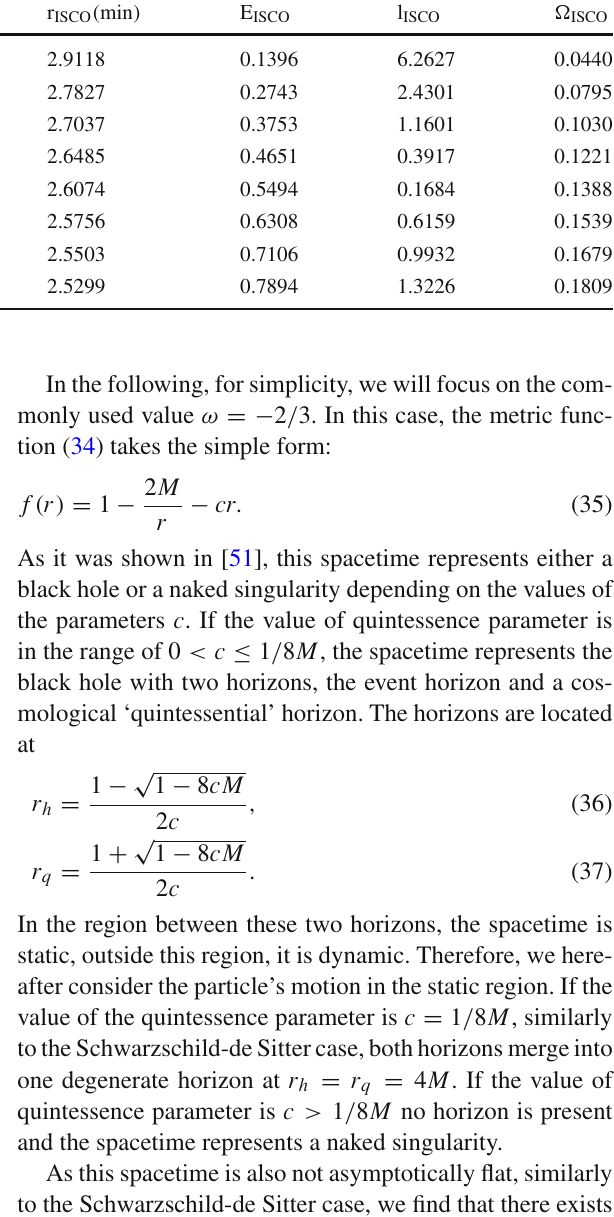
Table 1 Values of the